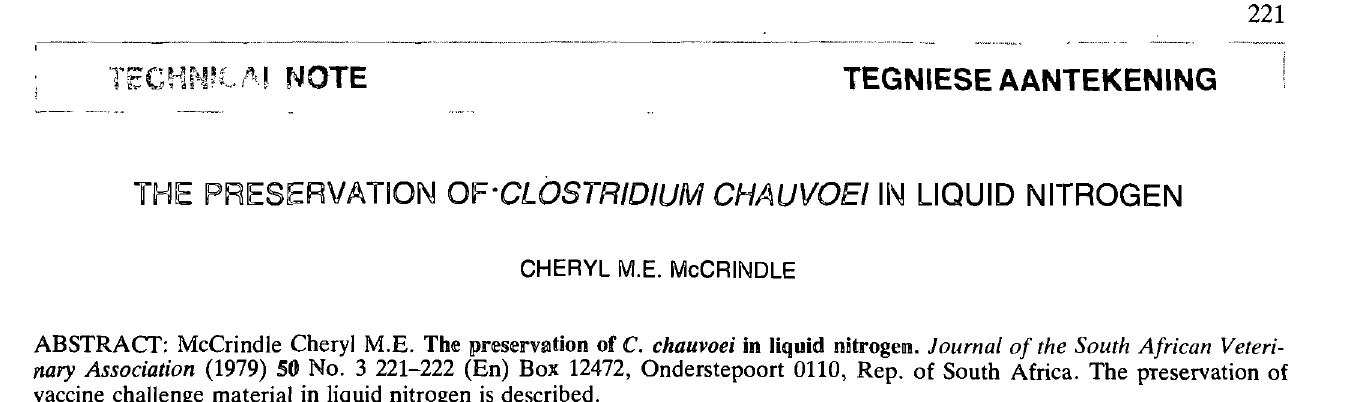
Table 1: THE INFLUENCE OF VARIOUS ADDITIVES ON THE VIRULENCE OF C. CHAUVOEI